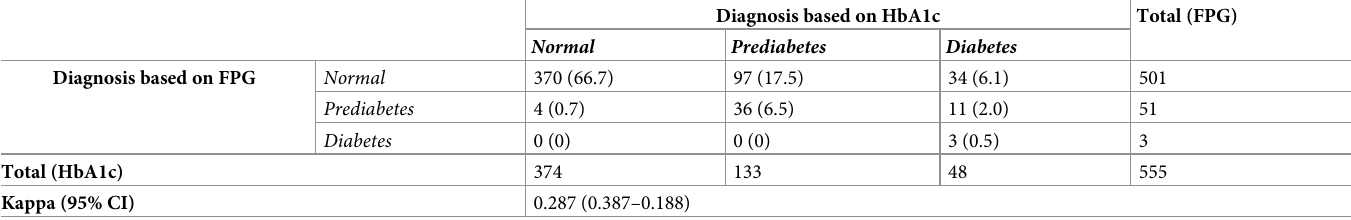
Table 2. Agreement between categories of diabetes and prediabetes based on fasting plasma glucose (FPG) and glycated hemoglobin (HbA1c) criteria among young female adults aged 17 to 25 years (n = 555) at UAEU.